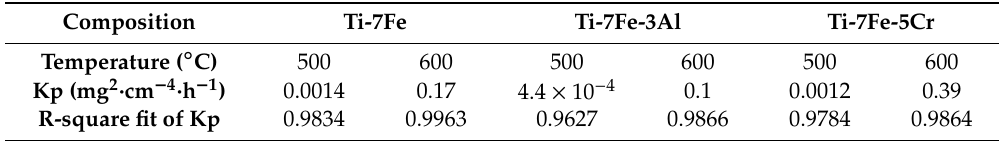
Table 5. Calculated parabolic oxidation rate constant Kp for di ff erent alloys and temperatures according to Wanger theory of oxidation.